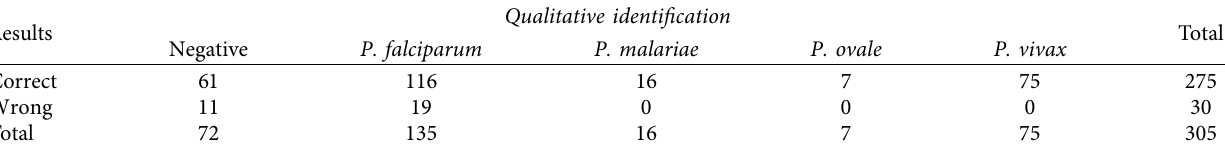
Table 5: Qualitative identification based on malaria microscopy by representatives from county